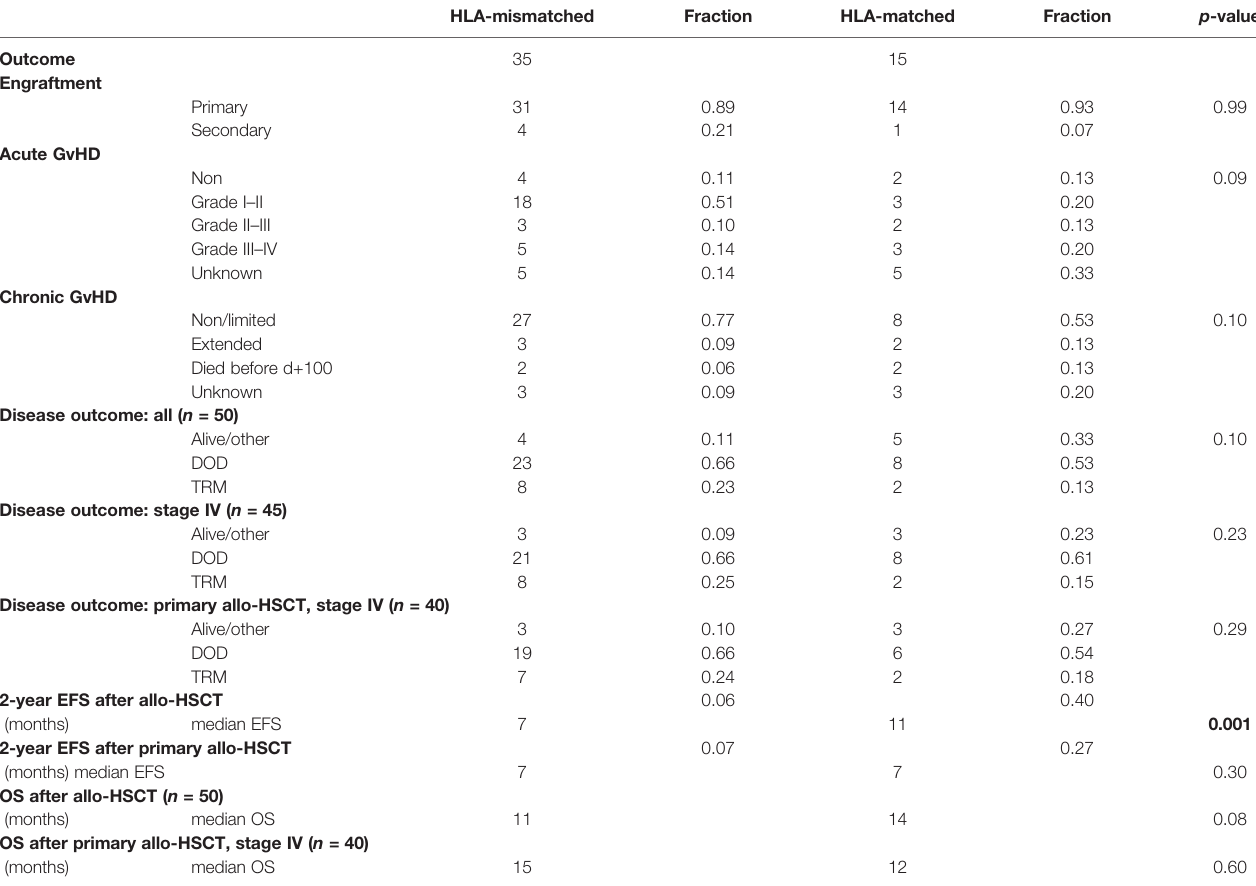
TABLE 2 | Disease course after